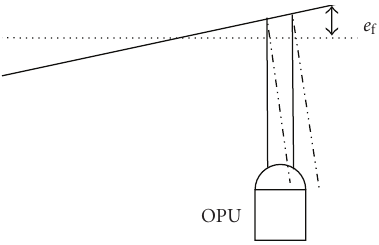
Figure 5: Illustration of the skewness of the disc. Notice that not all the reflected light do reach the OPU.